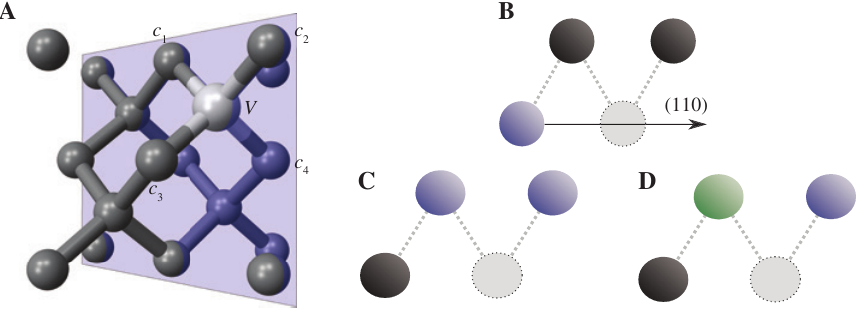
Figure 8: Schematics of the candidate defect structures of the ST1 center. (A) Is a cell of diamond showing a vacancy and the (110) reflection plane. The other figures are the different possible geometries represented by a (110) cross-section of the defect. If we let X and Y represent potential impurities, (B) is a next-to-nearest-neighbour substitution, labelled XCV; (C) is the nearest-neighbour substitutions of like atoms, labelled XVX; and (D) is nearest-neighbour substitutions of unlike atoms, labelled